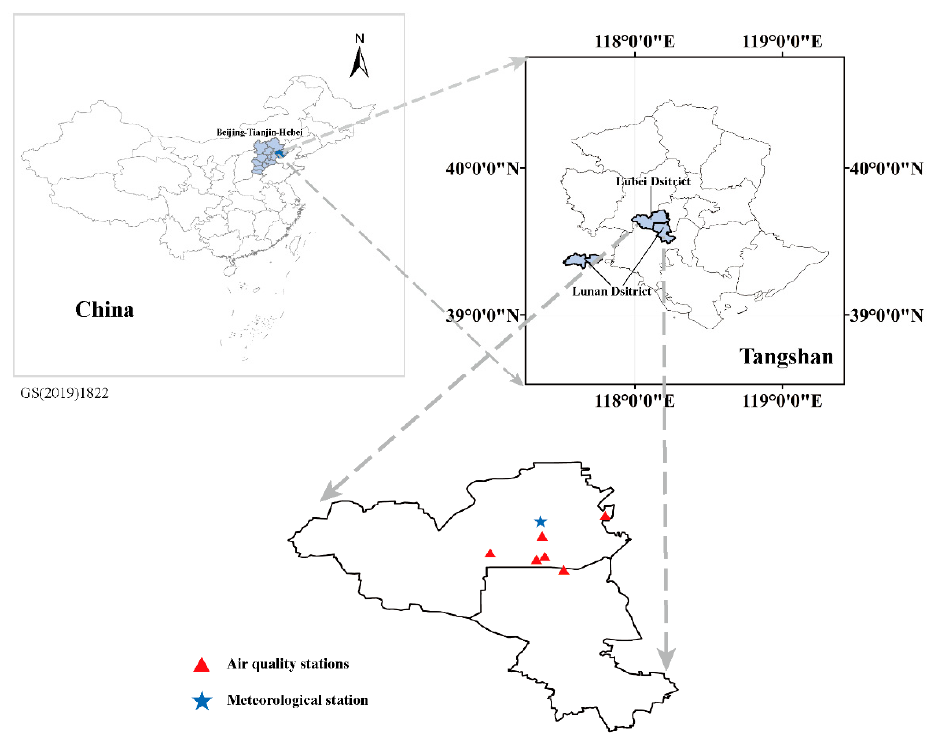
Figure 1. Location of Tangshan and distribution of meteorological and air quality stations .